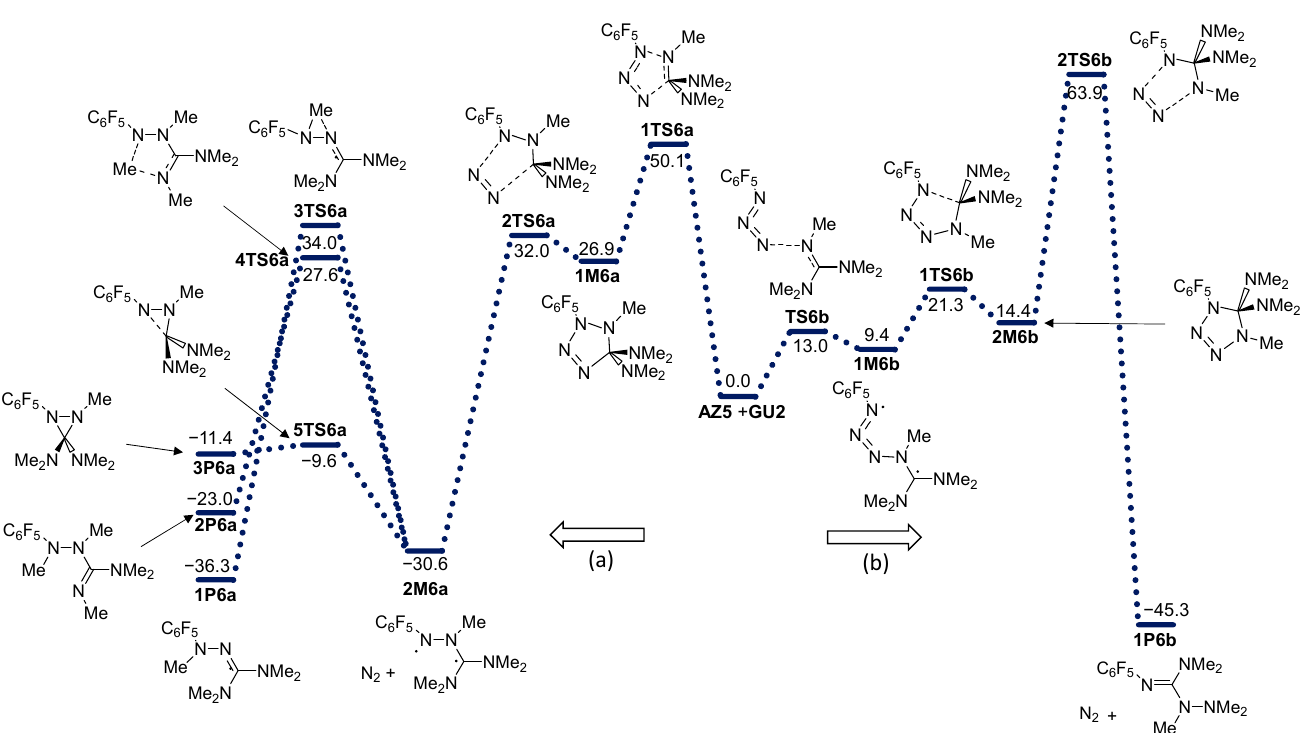
Figure 11. Energy profile for the addition of perfluorophenyl azide AZ5 with permethylated guanidine GU2 . Energies relative to reactants are given in kcal mol − 1 . ( a ) and ( b ) denote two modes of azide addition to GU .